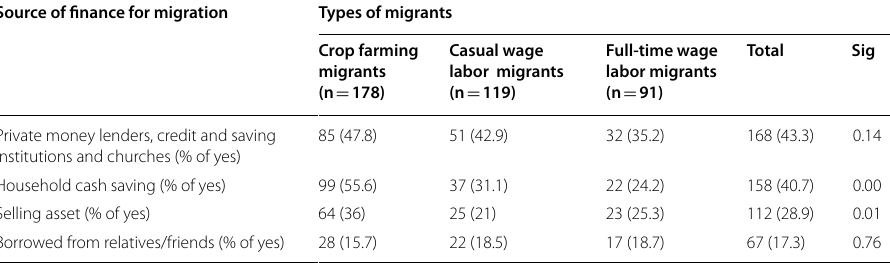
Table 2 Source of finance during last migration across types of migrants. Source : Own Household Survey (2015)